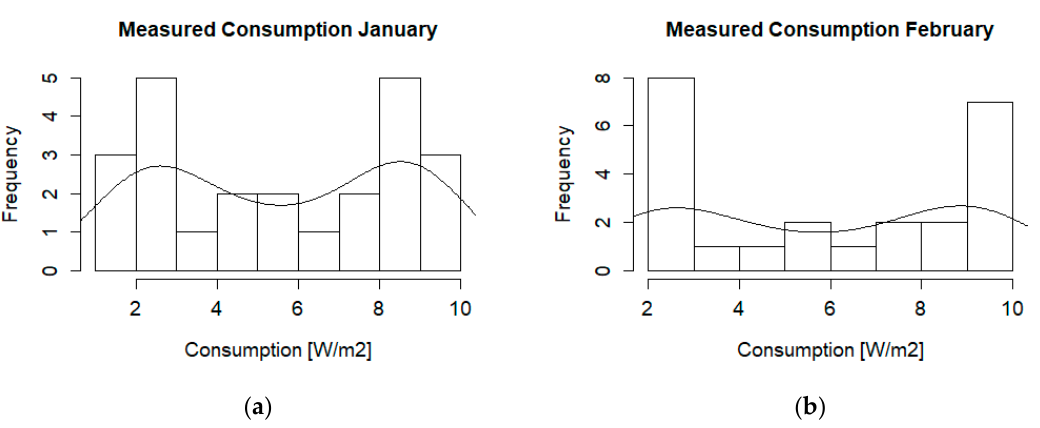
Figure 15. Histograms for tenants’ monthly consumption during weekdays: ( a ) January; ( b ) February.